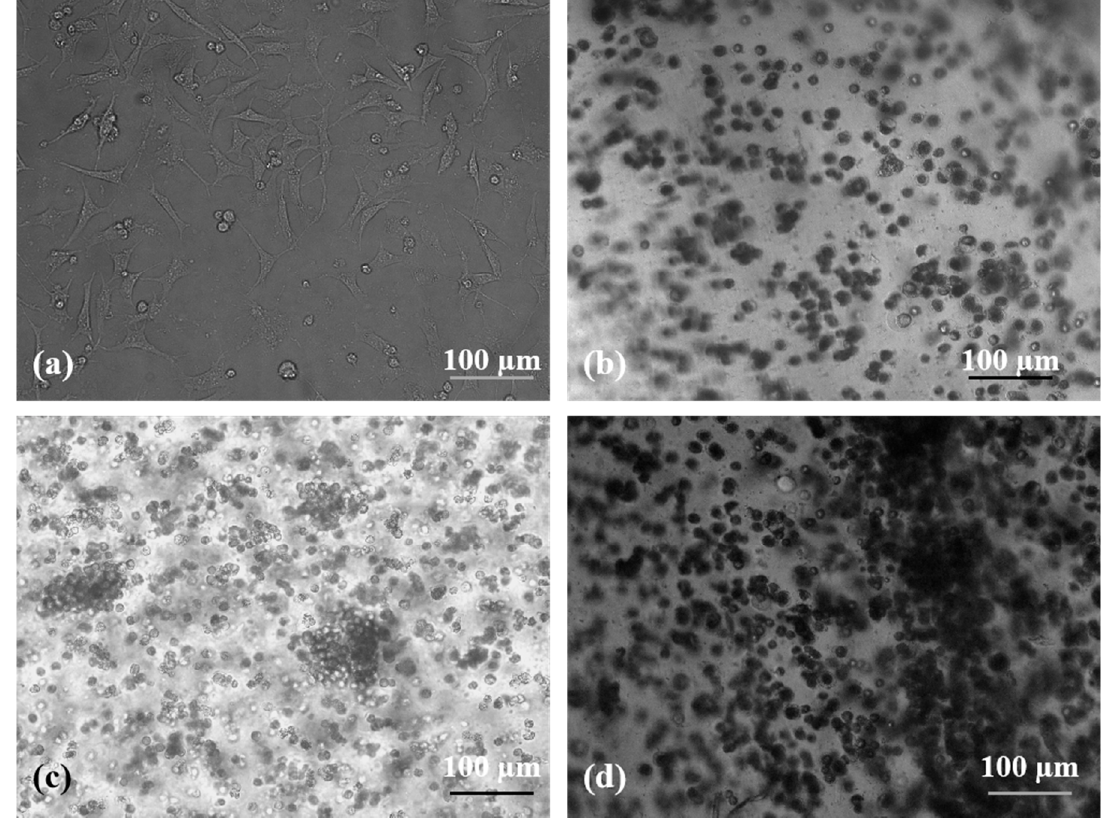
Figure 6. Human neuroblastoma SH-SY5Y cells cultured on a 2D plastic and in a 3D alginate-gelatin-interpenetrating polymer network (A-G-IPN): ( a ) an optical microscope image of SH-SY5Y cells cultured on a 2D plastic for 1 day. ( b ) An optical microscope image of SH-SY5Y cells cultured in a 3D A-G-IPN hydrogel for 1 day. (c) An optical microscope image of SH-SY5Y cells cultured in a 3D A-G-IPN hydrogel for 4 days. ( d ) An optical microscope image of SH-SY5Y cells cultured in a 3D A-G-IPN hydrogel for 7 days.